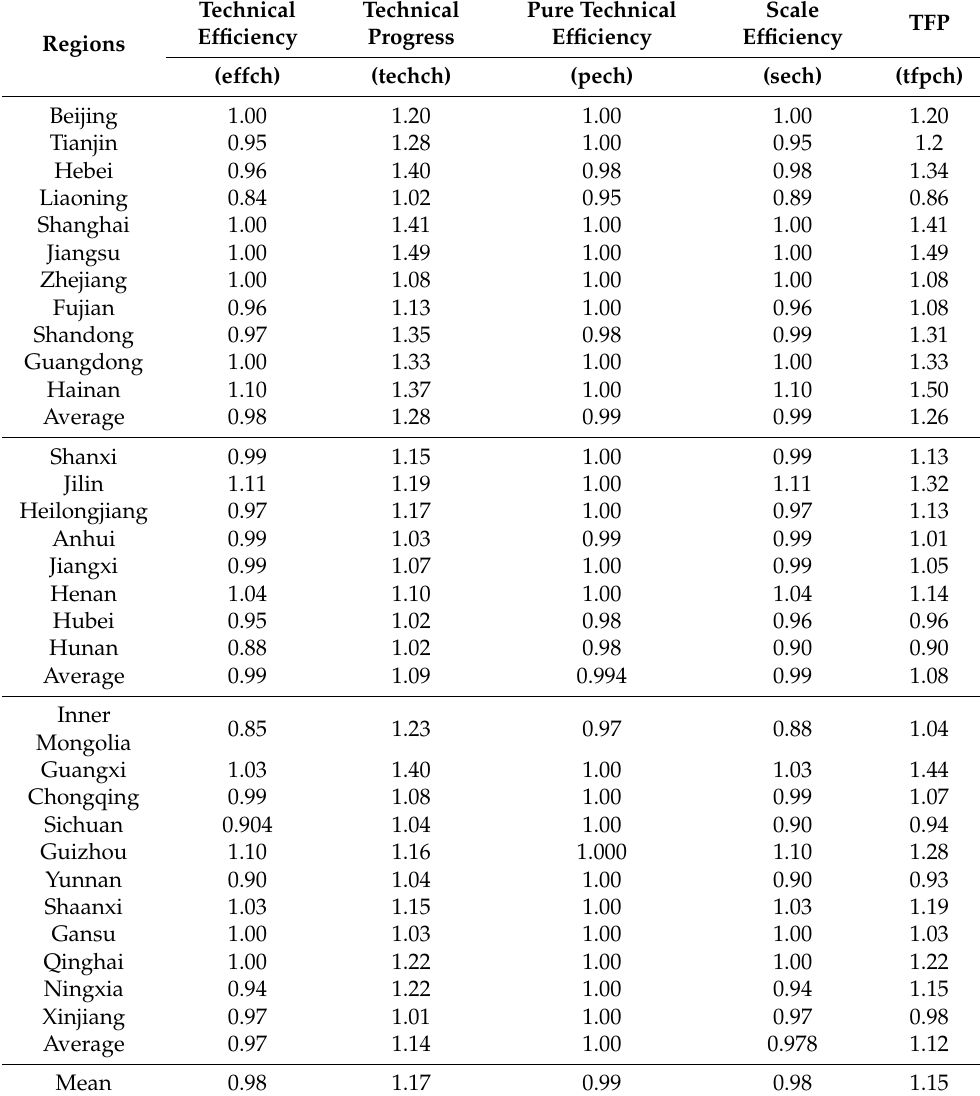
Table 9. Malmquist Index and Its Decomposition of Green Buildings’ Management Efficiency in Each